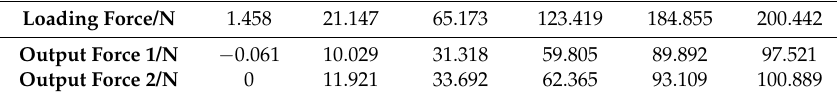
Table 2. Experiment 2 (the weight is 25 kg).